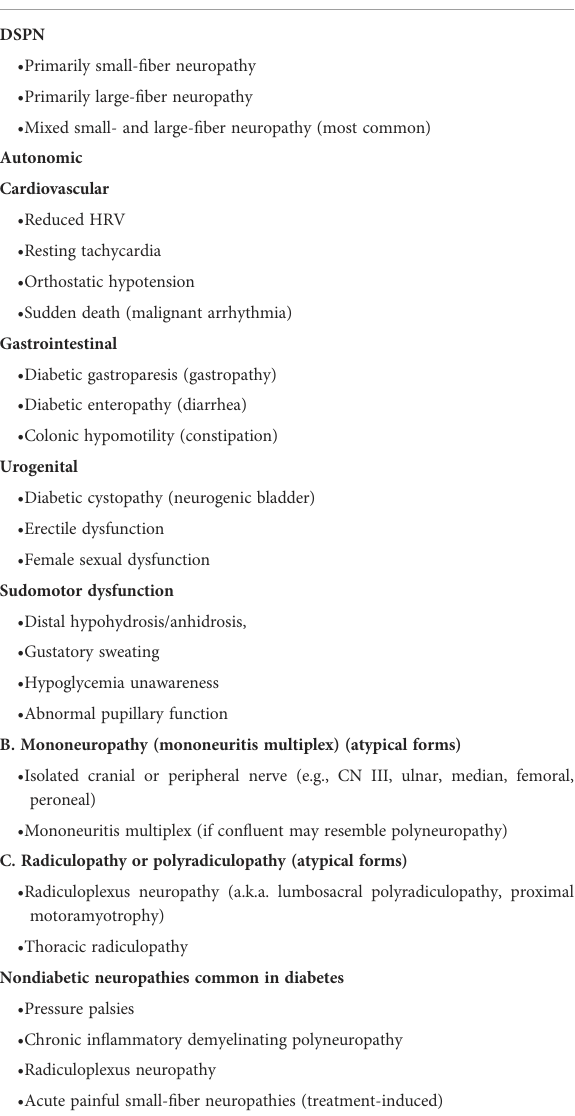
TABLE 1 Classi fi cation of diabetic